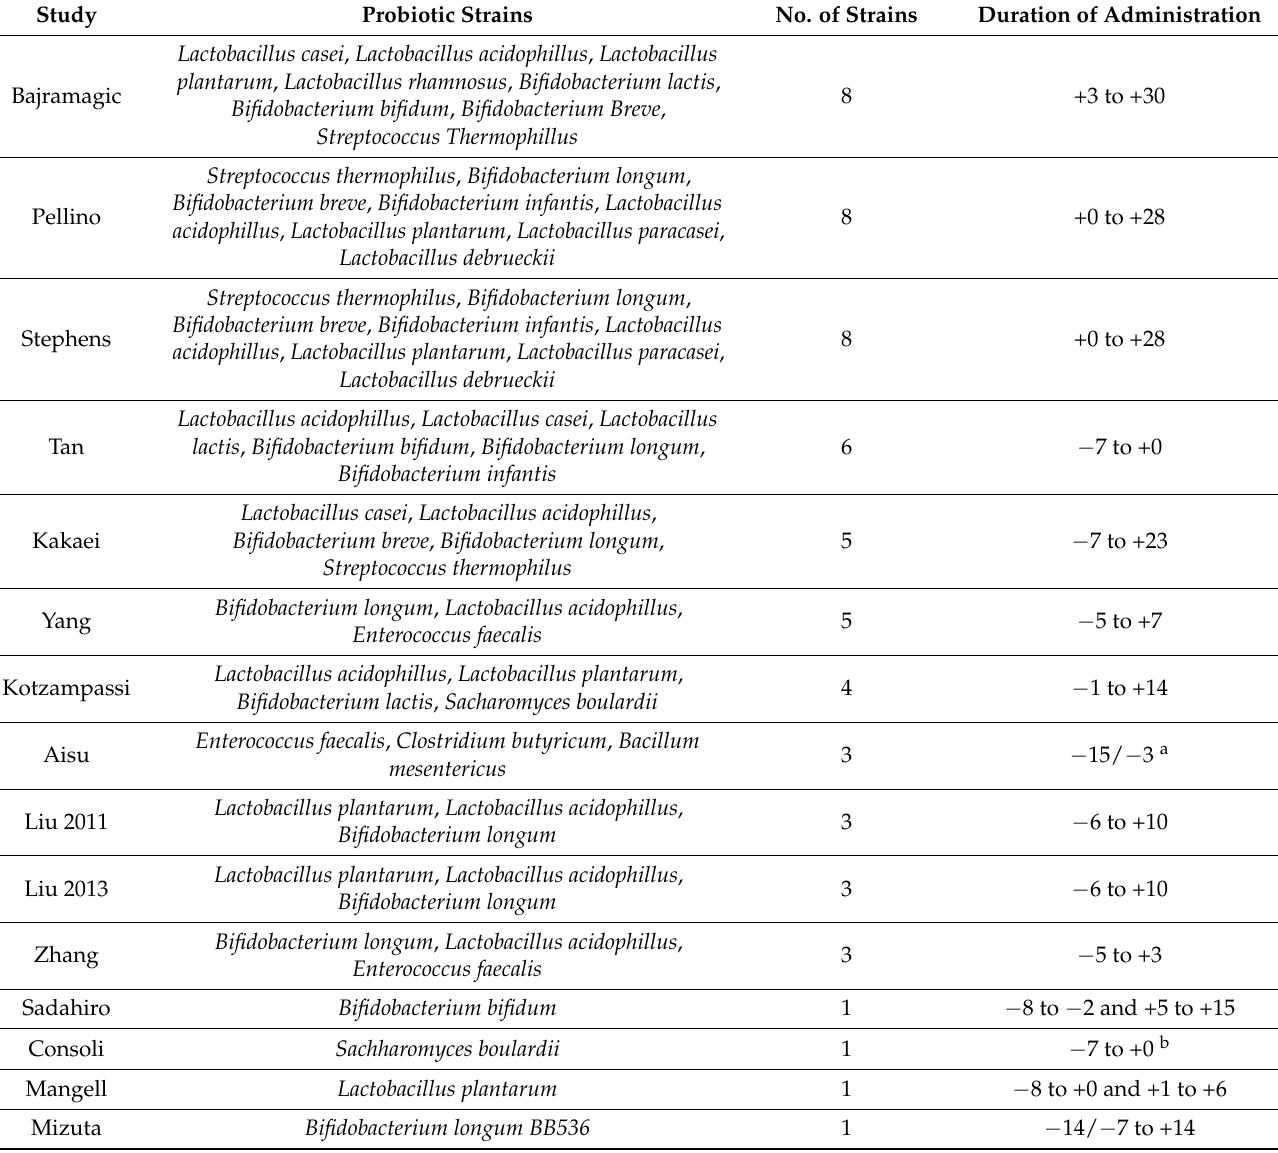
Table 4. Probiotic composition and the number of probiotic strains used in each RCT included in this study.